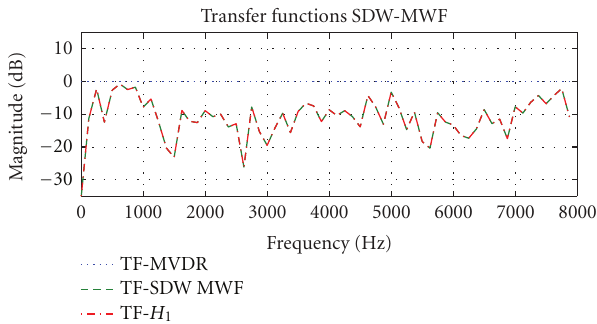
Figure 5: Comparison of the overall transfer function of the SDW- MWF and the ideal MVDR